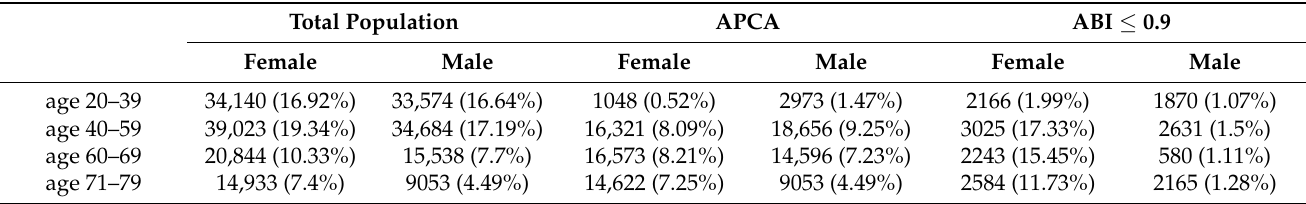
Table 1. Estimated prevalence of atherosclerotic plaques in carotid arteries and an ABI ≤ 0.9 in the local